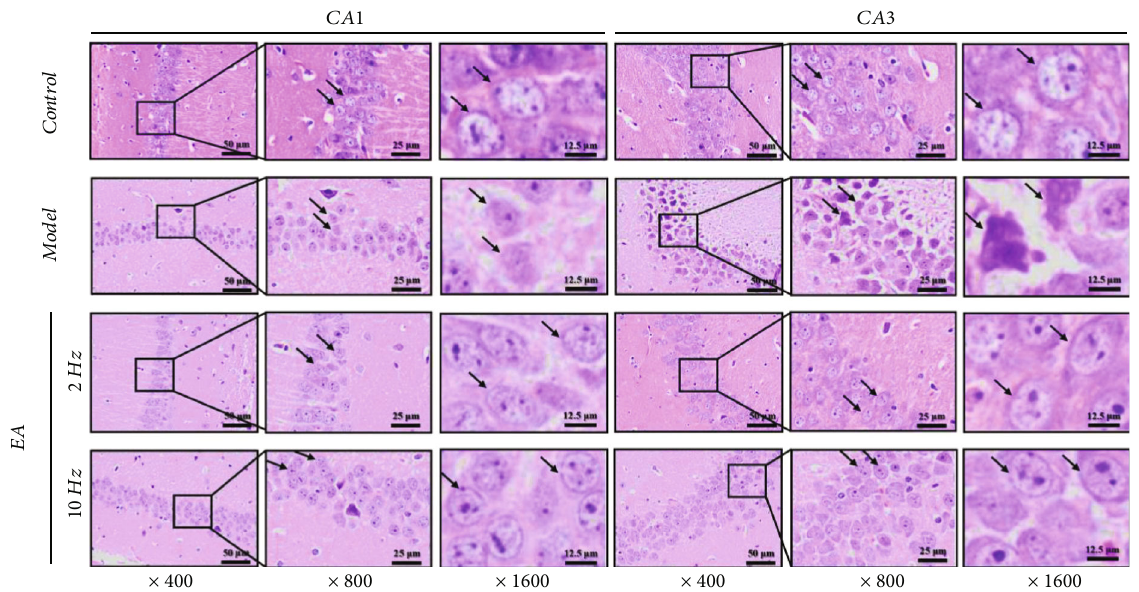
Figure 3: Electroacupuncture (EA) treatment was neuroprotective in the hippocampal CA1 and CA3 regions of SAMP8 mice. Magni fi cation times, × 400, × 800, and × 1600. Bar, 50 μ m, 25 μ m, and 12.5 μ